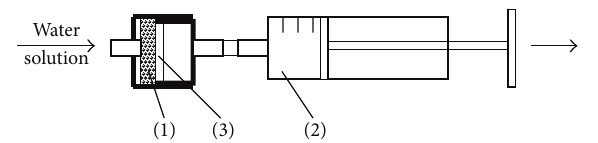
Figure 6: Pocket concentrator with special cell (1) based on medical syringe (2) for the test tool in the form of paper or PUF disc (3).